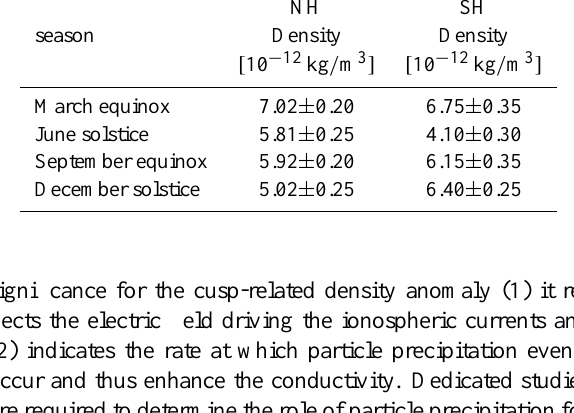
Fig. 11. Height profile of the Pedersen conductivities according to the electron concentration as derived from model runs of Mill- ward et al. (1999) for 14 December 2002, 09:30UT. This day is characterised by elevated solar activity (F10.7 = 167) and moderate geomagnetic activity ( K p = 2 . 7). Considered are the cases of ab- sence of precipitating particles (grey) and presence of precipitation (black).